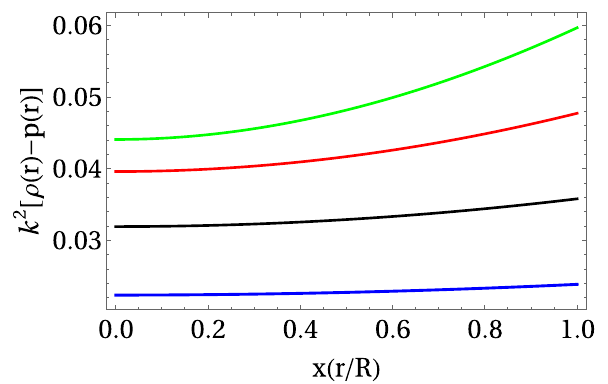
Fig. 4 k 2 [ ρ( r ) − p ( r ) ] for Model I: 0.1 (blue line), 0.15 (black line), 0.20 (red line) and 0.25 (green line)